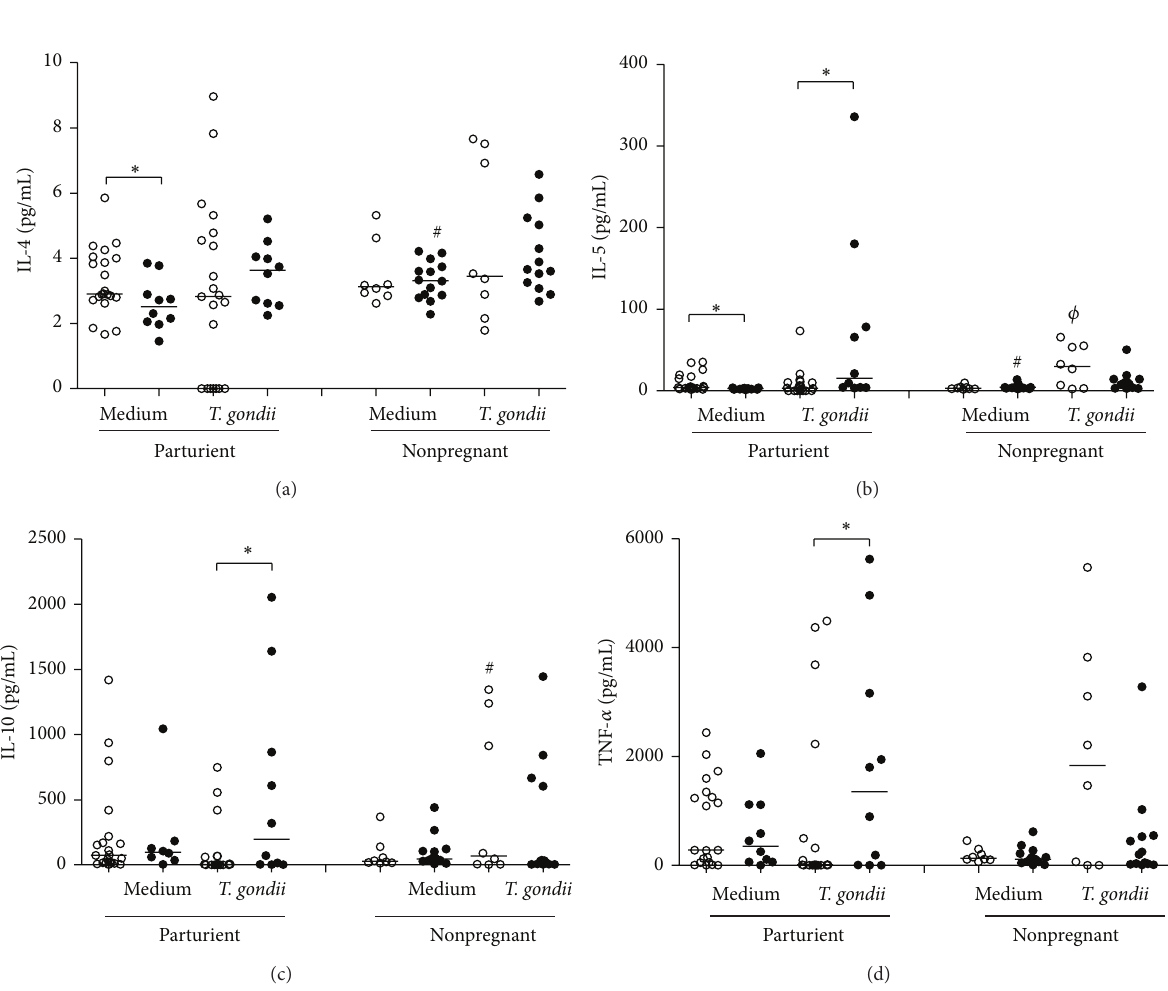
Figure 1: Cytokine production by PBMCs in culture supernatants stimulated with T. gondii . The horizontal line indicates the median, open circles indicate the T. gondii seronegative subjects, and filled circles indicate seropositive subjects. (a) ∗ IL-4 expression from cells of seronegative and seropositive parturient women without the stimulus; # IL-4 expression from cells of seronegative parturient and nonpregnant womenwithoutthestimulus;(b) ∗ IL-5expressionfromcellsofseronegativeandseropositiveparturientwomenwithoutthestimulusandafter stimulation with live tachyzoites; # IL-5 expression from cells of seronegative parturient or nonpregnant women without the stimulus; 𝜙 IL-5 expression from cells of seropositive parturient or nonpregnant women after stimulation with live tachyzoites; (c) ∗ IL-10 expression from cells of seronegative or seropositive parturient women after stimulation with live tachyzoites; # IL-10 expression from cells of seropositive parturient or nonpregnant women after stimulation with live tachyzoites; (d) ∗ TNF- 𝛼 expression from cells of seropositive or seronegative parturient women after stimulation with live tachyzoites. ( ∗ 𝑃 < 0.05 , Wilcoxon test). # ,𝜙 Significant differences between the PMBCs of